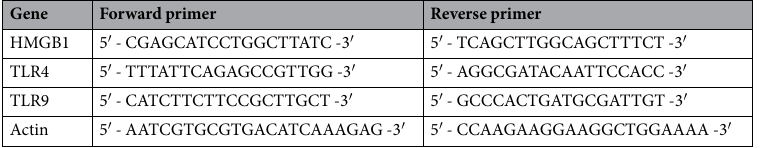
Table 1. Sequences of oligonucleotide primers used for